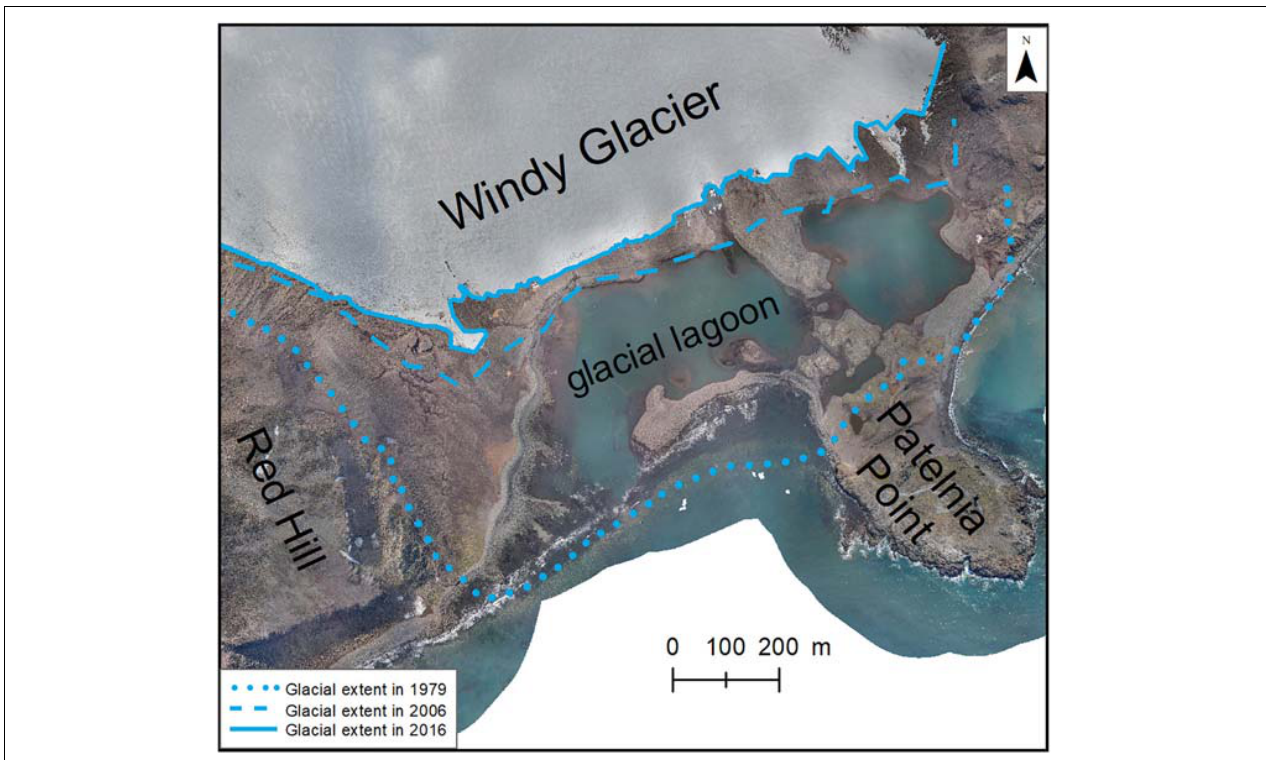
FIGURE 2 | Retreat of Windy Glacier since 1979; sources: UAV-based imagery from 2016, Google Earth (glacial extent in 2006) and orthophoto of Pudełko (2003) showing glacial extent in